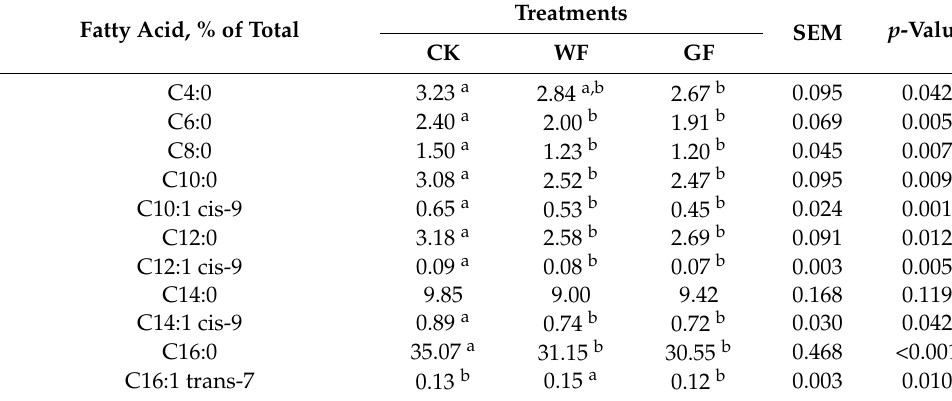
Table 4. Milk fatty acid composition of cows in different treatment groups. Fatty Acid, % of